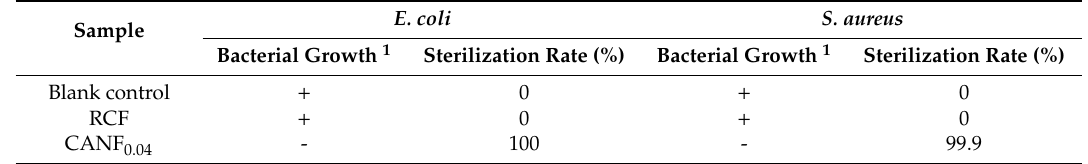
Table 1. Test results of films’ contact sterilization ability.